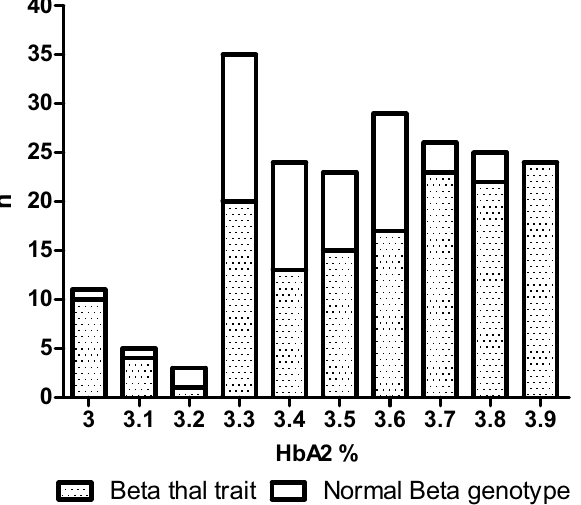
Figure 1. Distribution of study population according to HbA 2 levels and β genotype